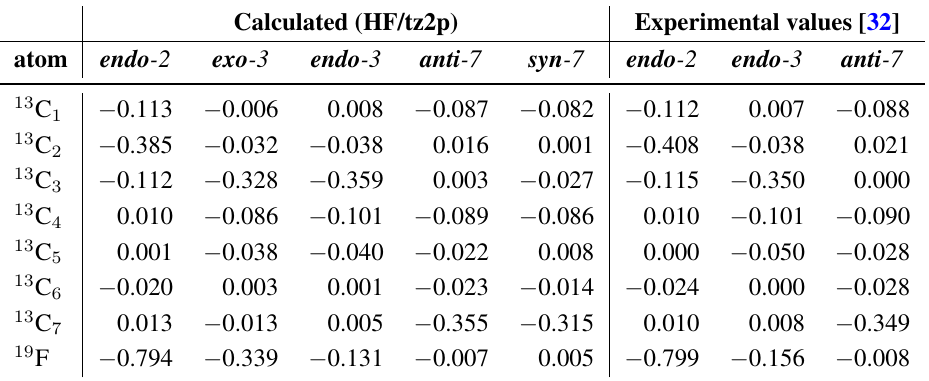
Table 3. Secondary isotope shifts of exo -2-fluoronorbornane in ppm at HF/tz2p level and for T = 300 K and experimental values with deuterium labels on different positions in the molecule.